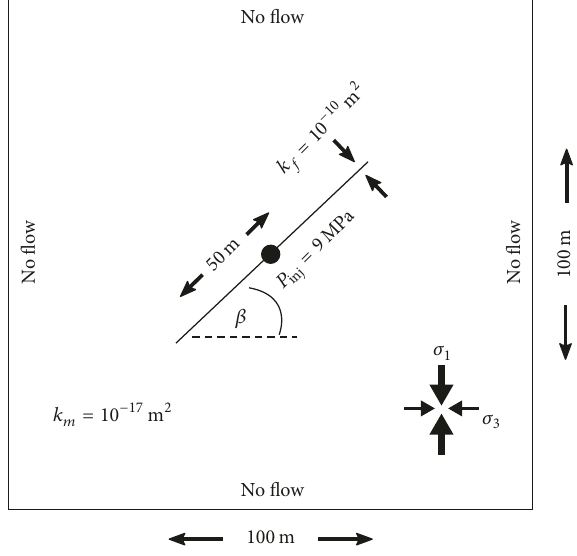
Figure 9: Numerical setup to evaluate the influence of fracture orientation and thermal stress on shear failure potential. A constant injection pressure is applied to the middle of the fracture. On the outer boundaries, a no-flow boundary condition is